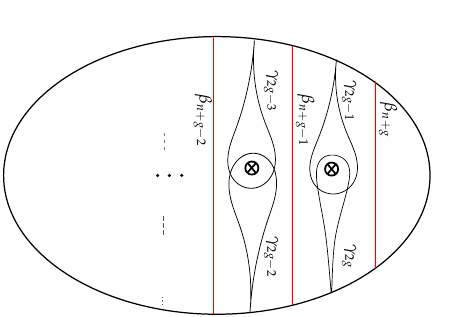
and b (cid:48) 1 1 g n + g − −